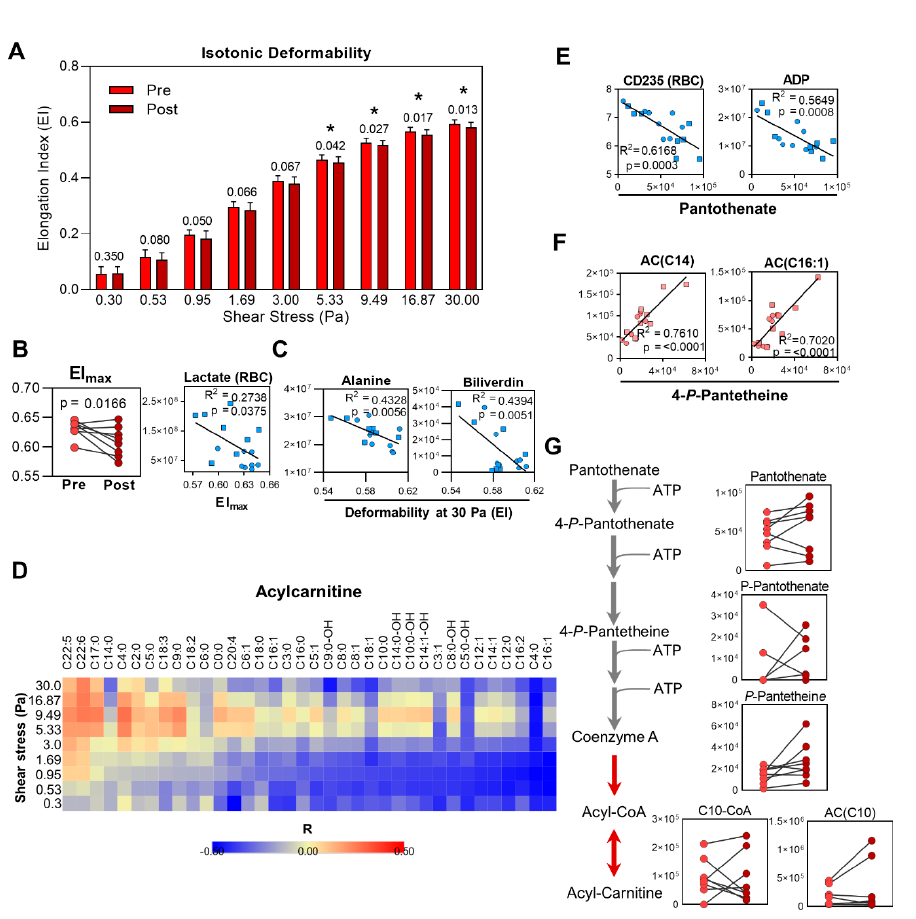
Figure 6. Red blood cell deformability changes during exercise. ( A ) RBC deformability over a gradient of shear stress pressures using samples isolated before (Pre) and after (Post) cycling is shown, with corresponding p -values indicated above the bars at each shear stress pressure. Statistically significant differences (*, p < 0.05) are indicated. ( B ) Maximum elongation index (EI max ) at Pre and Post time points is shown (left). The Pearson correlation plot between RBC lactate ( y -axis given in arbitrary units, AUs, for lactate) and EI max at the Pre ( ○ ) and Post ( (cid:0) ) time points is shown. ( C ) Correlation plots for alanine and biliverdin with deformability at 30 Pa. The measured peak areas (AUs) for each metabolite are indi- cated on the respective y -axis. ( D ) A heat map showing the Pearson correlation coefficients between various Acylcarnitines measured by metabolomics and deformability over the shear stress gradient is shown. Values are colored from blue to yellow to red according the correlation coefficient ( R ) of − 0.5 to 0 to 0.5, respectively. Correlation plots are shown for the top two correlating parameters with ( E ) pantothenate and ( F ) 4-phospho-panteteine. The x - and y -axis refer to peak areas (AU) of each respective metabolite. ( G ) A pathway for coenzyme A (CoA) synthesis is shown, along with the correspond- ing values measured by metabolomics at the Pre (left) and Post (right) time points, given in arbitrary units (AUs) on the y -axis. Table 3. Metabolite correlates with deformability. Alanine